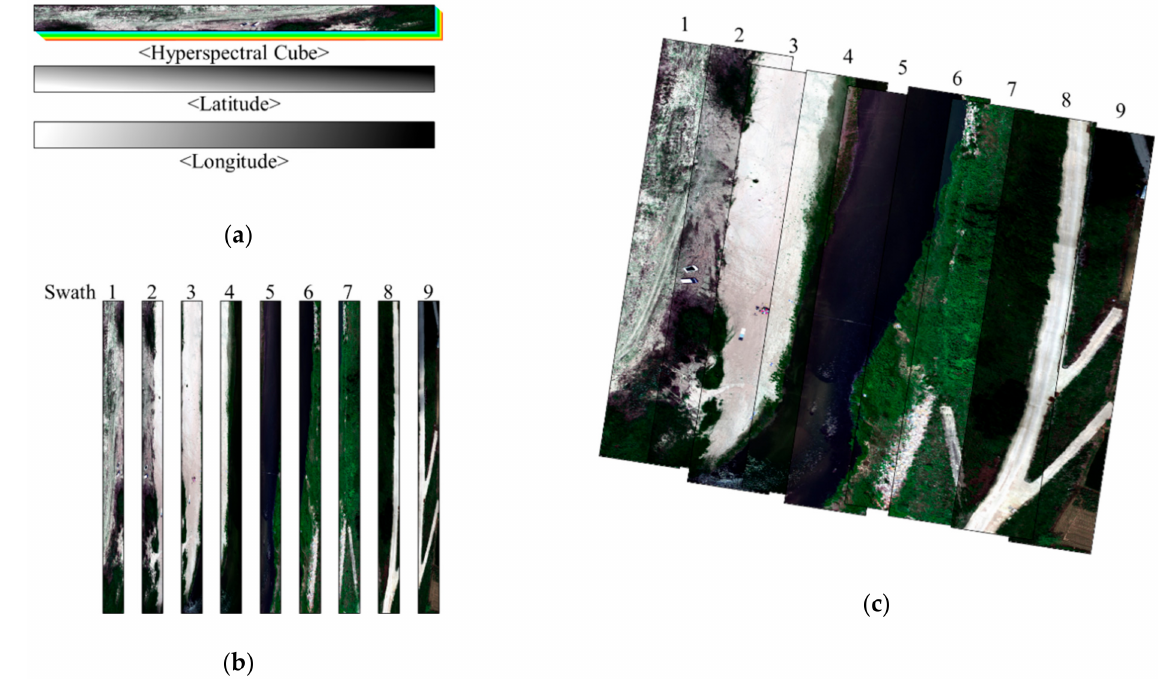
Figure 10. Overview of hyperspectral image data collection: ( a ) single-swath hyperspectral imagery; ( b ) hyperspectral image swath dataset created from multiple flights; ( c ) georeferencing results—in which a location was allocated to each pixel, and the mosaic that combined the multiple images into one image was